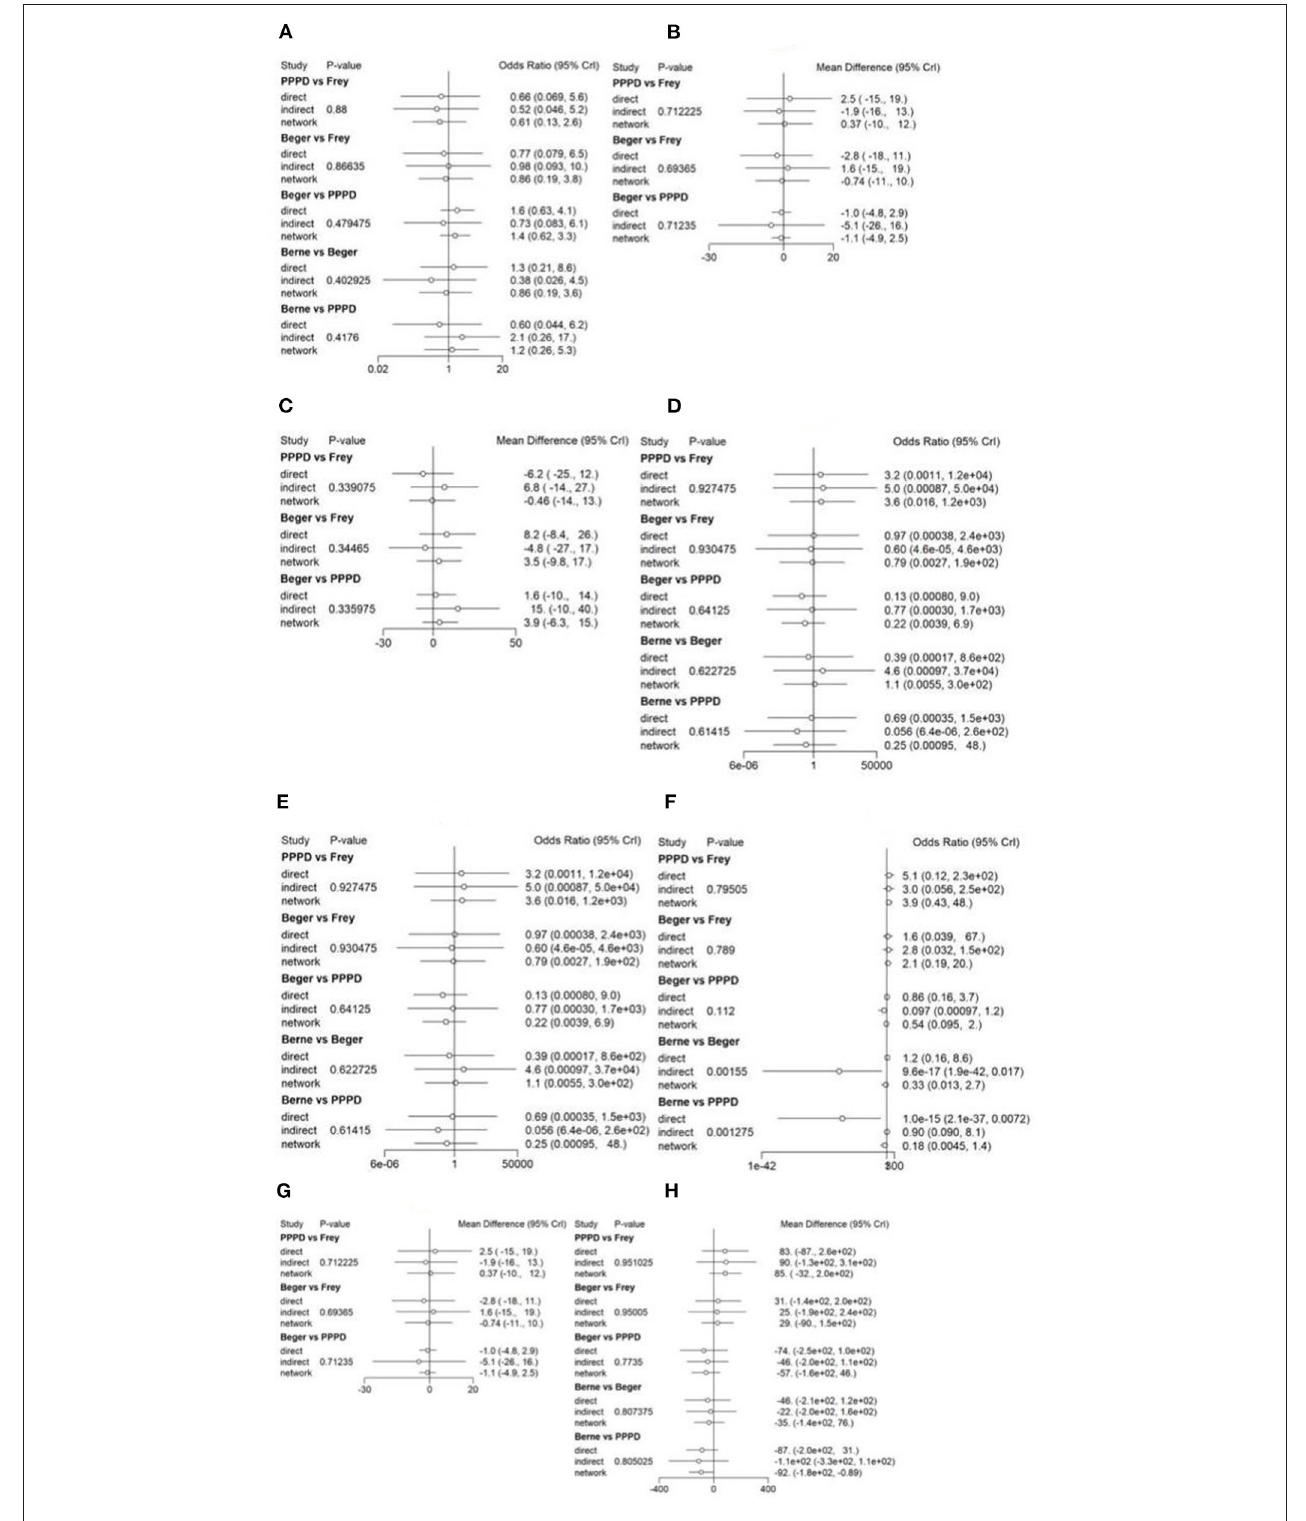
FIGURE 3 | Forest plot of treatment comparisons. The results of continuous variables were estimated as weighted mean difference (WMD) with their corresponding 95% confidence interval (CI), while categorical variables were expressed as odds ratio (OR) with 95% CI. (A) Forest plot of short-term pain relief; (B) Forest plot of long-term pain relief; (C) Forest plot of quality of life; (D) Forest plot of pancreatic exocrine function deficiency; (E) Forest plot of pancreatic endocrine function deficiency; (F) Forest plot of morbidity; (G) Forest plot of long-term mortality; (H) Forest plot of operation time.